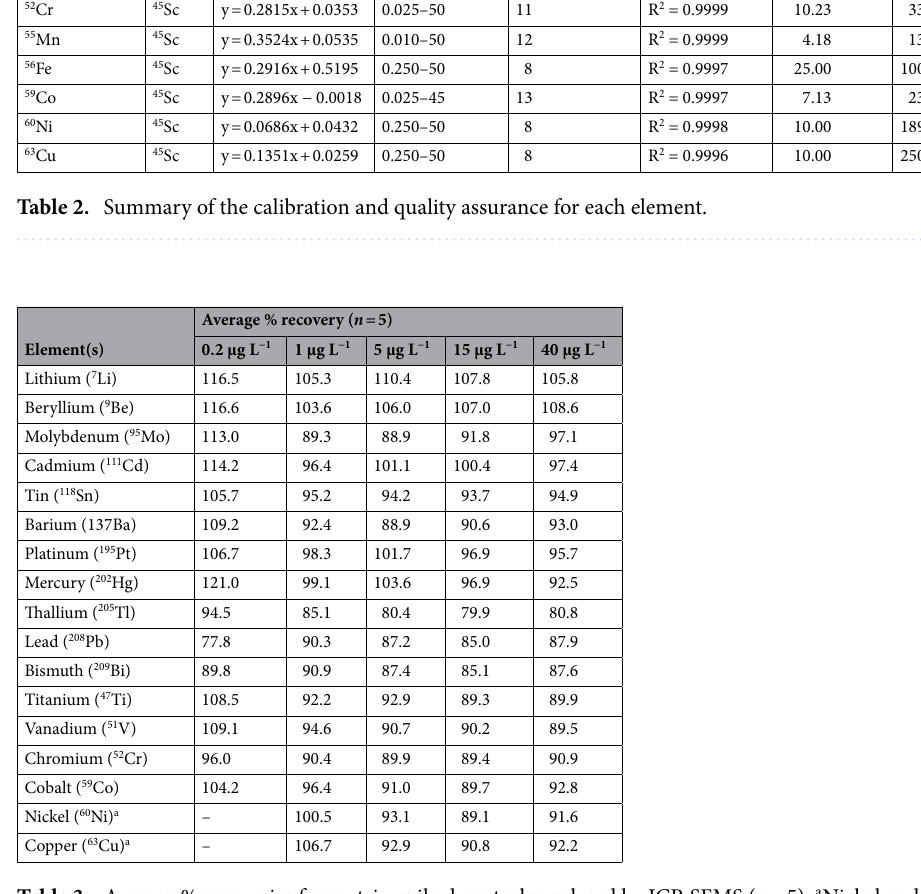
Table 3. Average % recoveries for matrix-spiked controls analysed by ICP-SFMS ( n = 5). a Nickel and copper have LOQs of 0.25 µg L −1 , which is above the lowest (0.2 µg L −1 ) control level, hence they have not been assessed at the 0.2 µg L −1